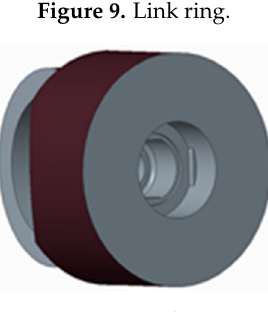
Figure 9. Link ring.